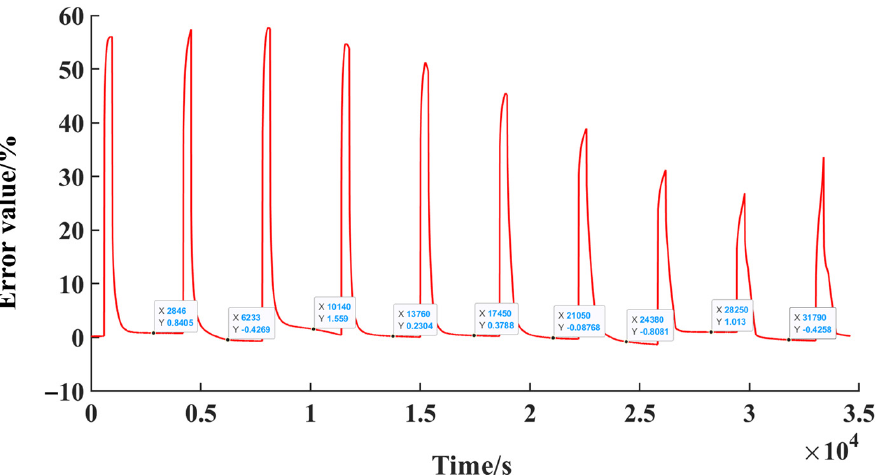
Figure 11. Relative errors between the XKF estimated and reference values (experimental values) of SOC.